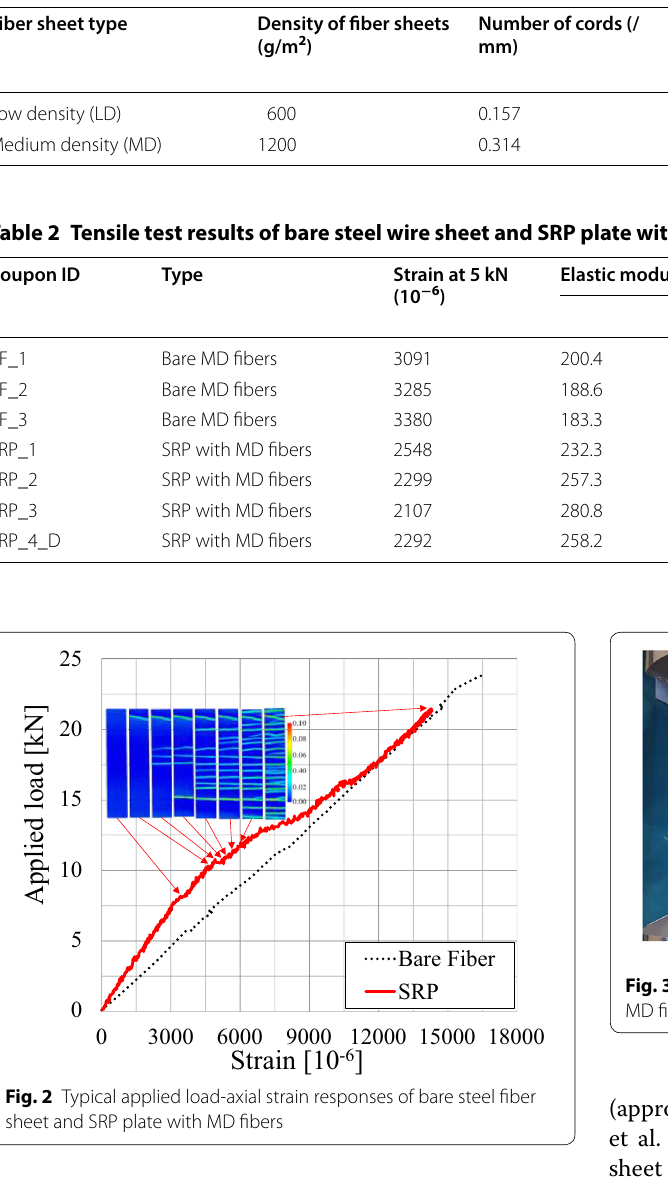
Table 1 Properties of fibers provided by the manufacturer (Kerakoll 2020)